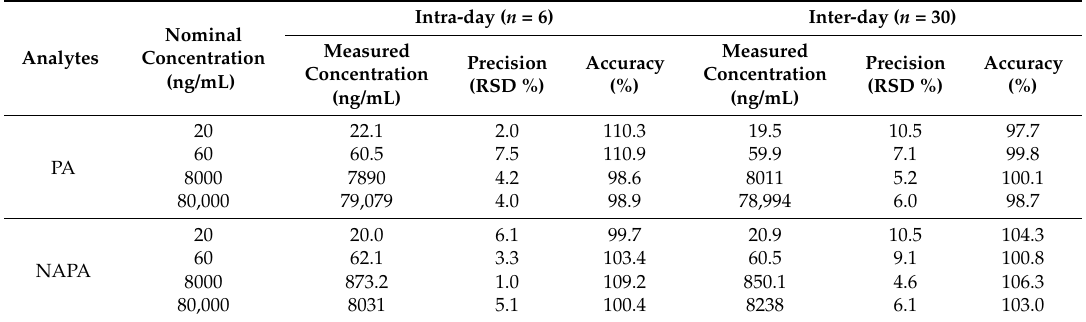
Table 1. Accuracy and precision of procainamide and N -acetylprocainamide in